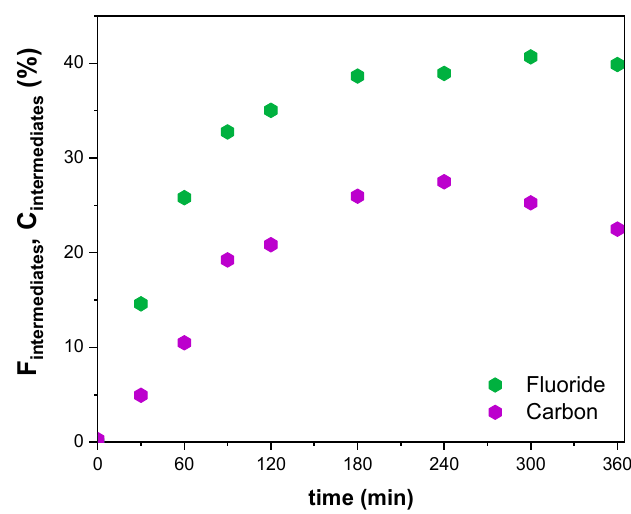
Figure 4. Ratio of fluorine and carbon atoms in the chemical intermediates. Operating conditions: [PFOA] 0 : 100 mg/L, j: 7.9 mA/cm 2 , electrolyte: 3.5 mM Na 2 SO 4 , T: 25 °C, pH 0 : 4.